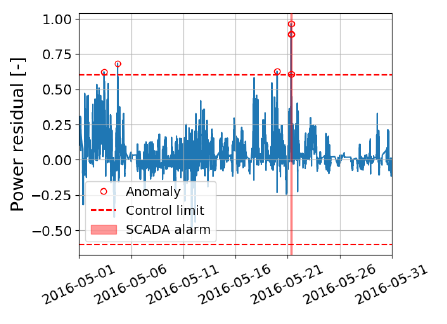
Figure 25. Power residuals of standalone SCADA model applied to raw SCADA data of May